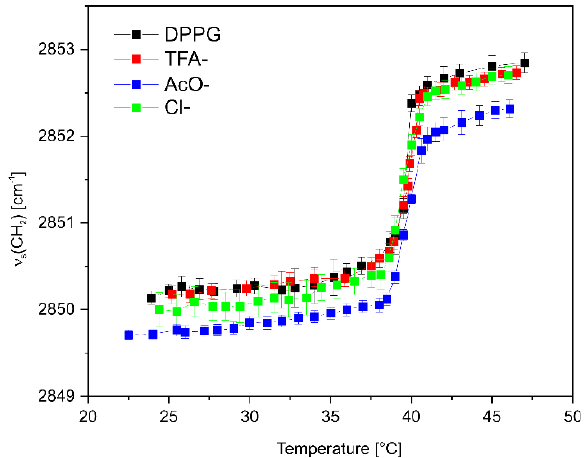
Figure 6. Frequency changes in the ν s (CH 2 ) stretching vibrations of DPPG vs. temperature before and after addition of C 16 -KKKK-NH 2 with various counterions.